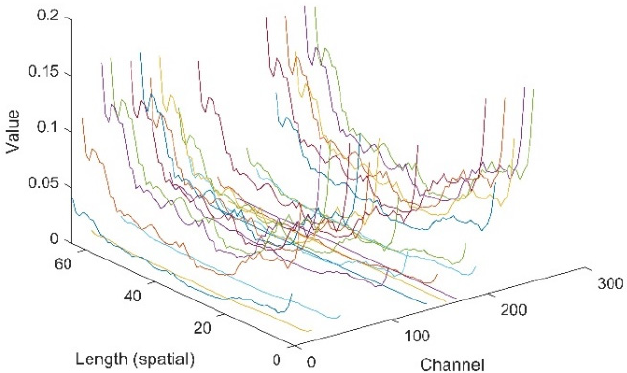
Figure 9. The weights of the attention unit.